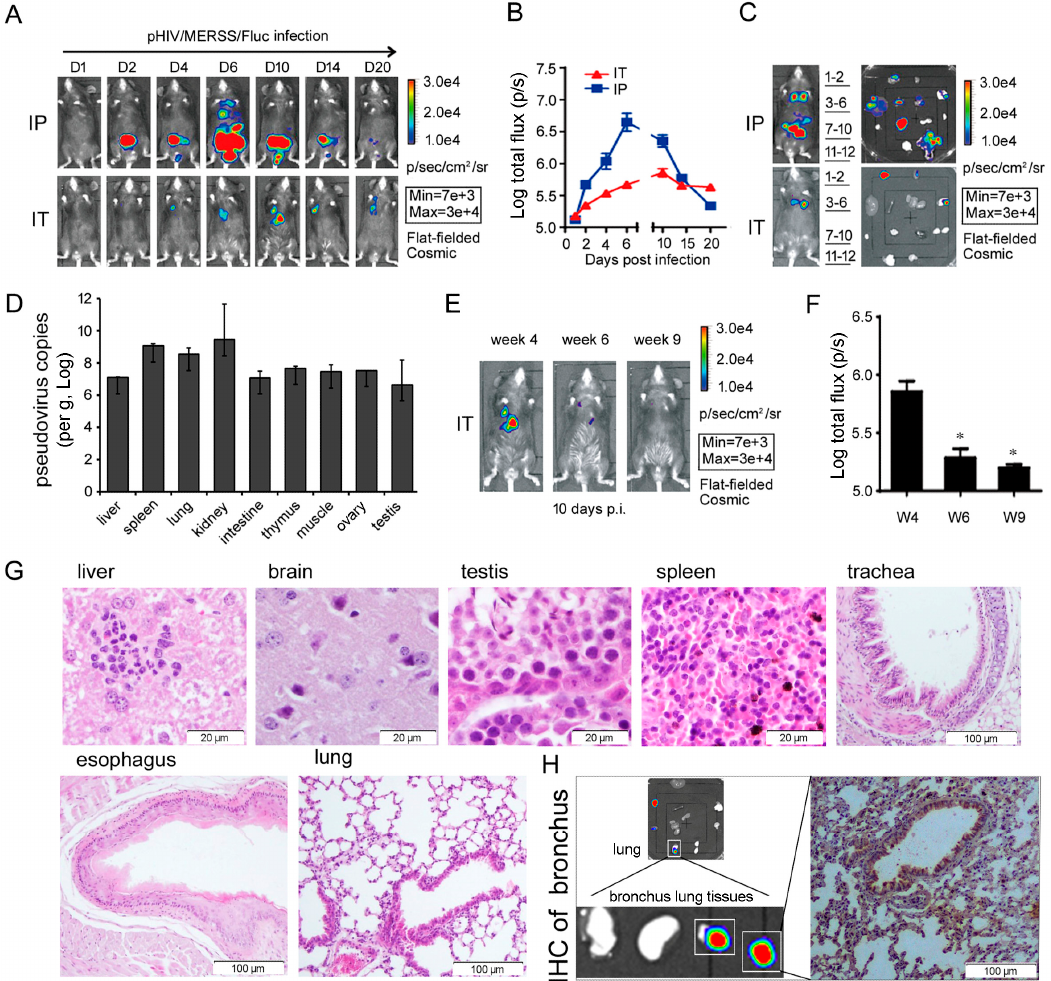
Figure 4. Establishment of the R26-hDDP4 knockin model of infection with MERS-CoV pseudovirus. ( A – C ) Four-week-old R26-hDPP4 mice were inoculated with 1.27 × 10 7.5 TCID 50 (I.P. route) or 3.8 × 10 6.5 TCID 50 (I.T. route) of pHIV/MERSS/Fluc per animal. ( B ) Bioluminescent images (BLI) are shown